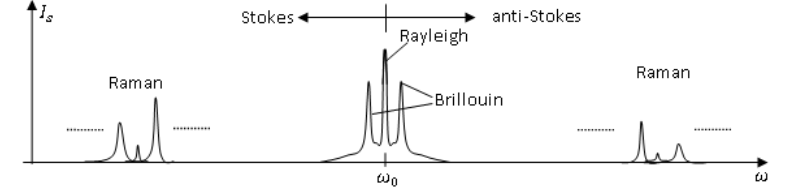
Figure 1. Typical spontaneous scattering spectrum from solid state